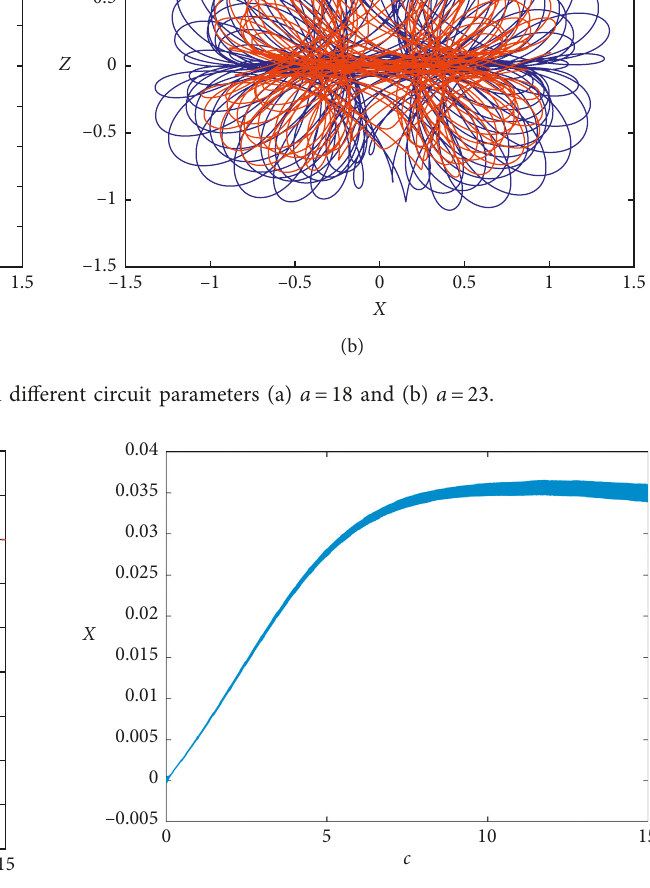
Figure 9: Bifurcation diagrams of chaotic system (6) versus pa- rameter c